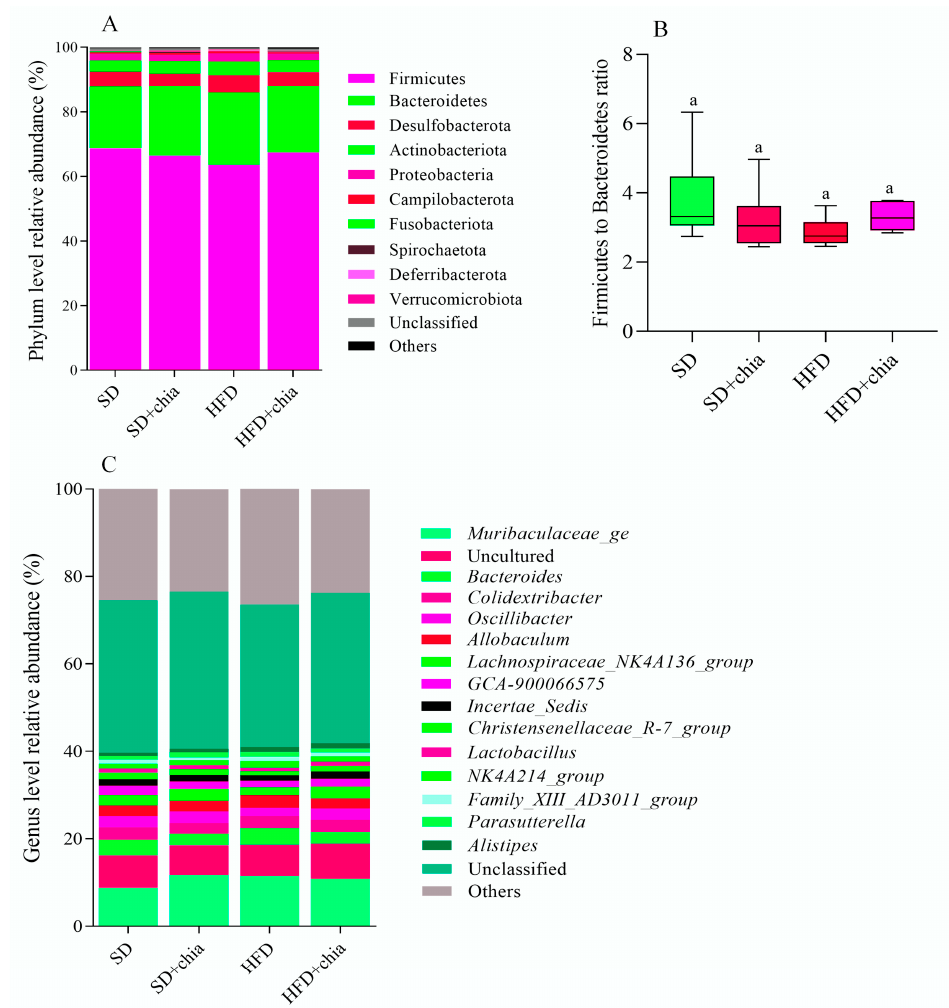
Figure 4. Relative abundances of bacterial microbiota composition at phylum and genera level of young Wistar rats, after 35 days of treatment. ( A ) Relative abundance of each identified phylum. ( B ) Firmicutes to Bacteroidetes ratio. ( C ) Genera relative abundance. n = 6/group. SD: standard diet; SD+chia: standard diet + chia; HFD: high-fat diet; HFD+chia: high-fat diet + chia. Only phyla with abundance >0.2% and genera with abundance >1% in at least one group are displayed. The data were analyzed with FDR correction. Treatment groups indicated by the same letter are not significantly different ( p < 0.05). * Indicates differences between the groups by the t-test, at 5% probability, in the comparison of the groups that received the same diet, either with or without chia (SD × SD+chia and HFD × HFD+chia).